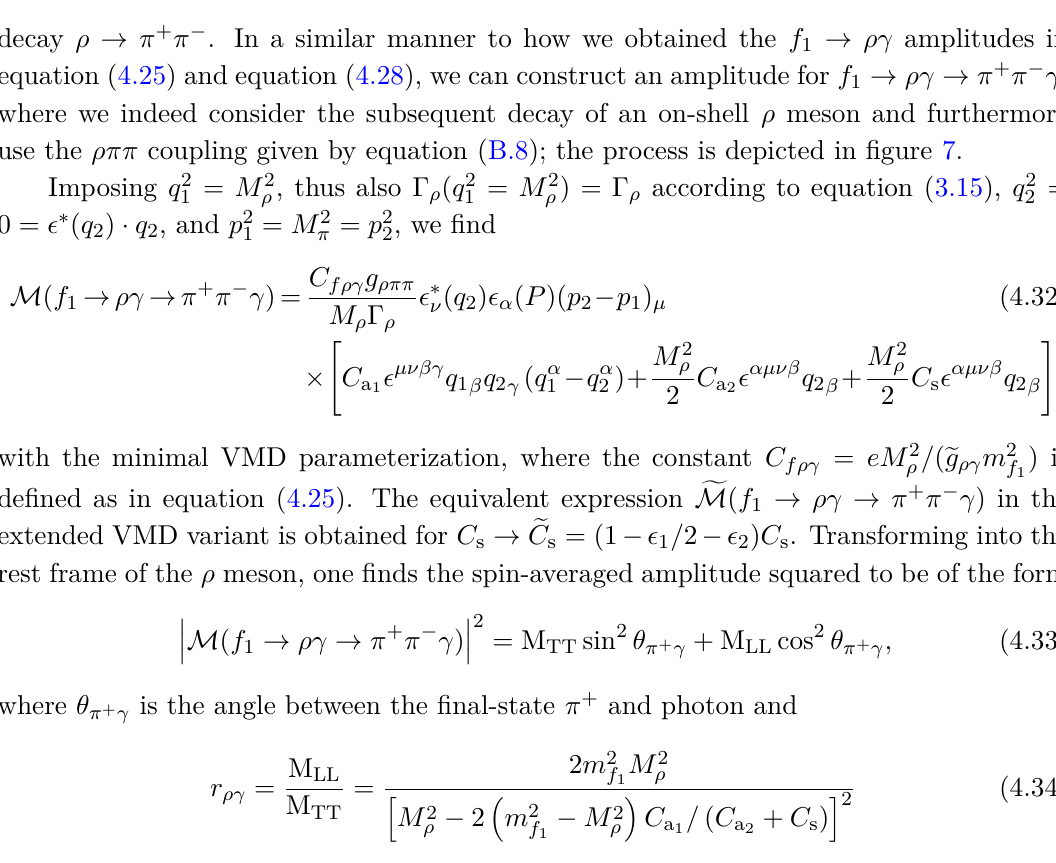
Figure 7 . Feynman diagram for f 1 → ργ → π + π − γ consistent with M ( f 1 → γ ∗ γ ∗ )